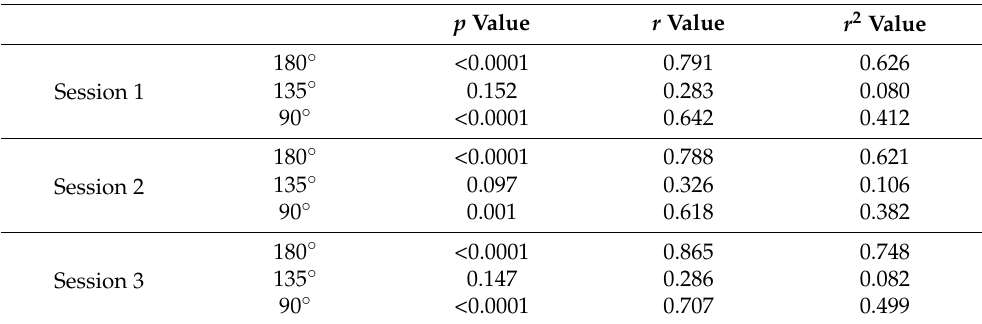
Table 13. Correlation between ASH test results using Active5™ and K-Force plates in the nondomi- nant upper limb in the male group.